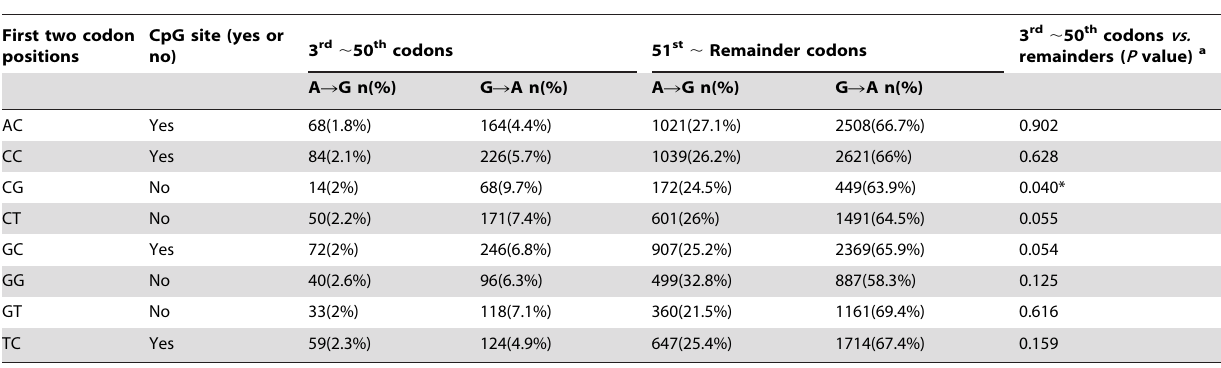
Table 2. A « G fourfold degenerate site